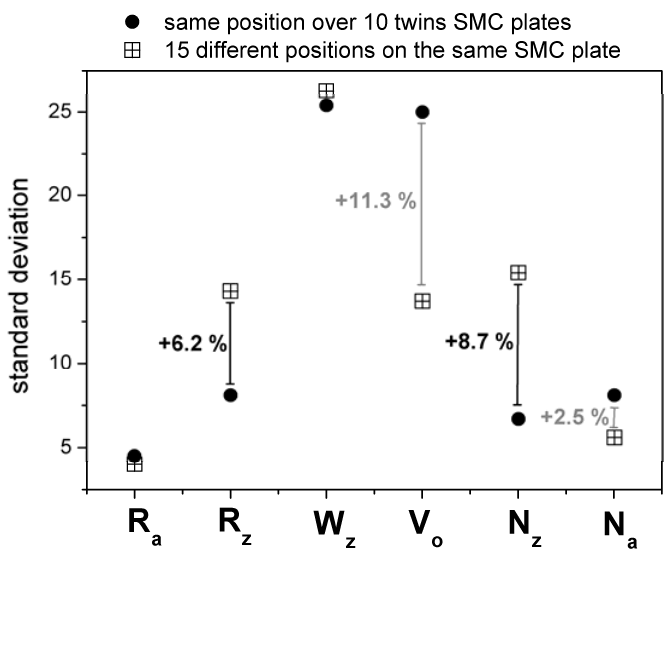
Figure 15. Impact of sampling (positioning) criteria on statistical